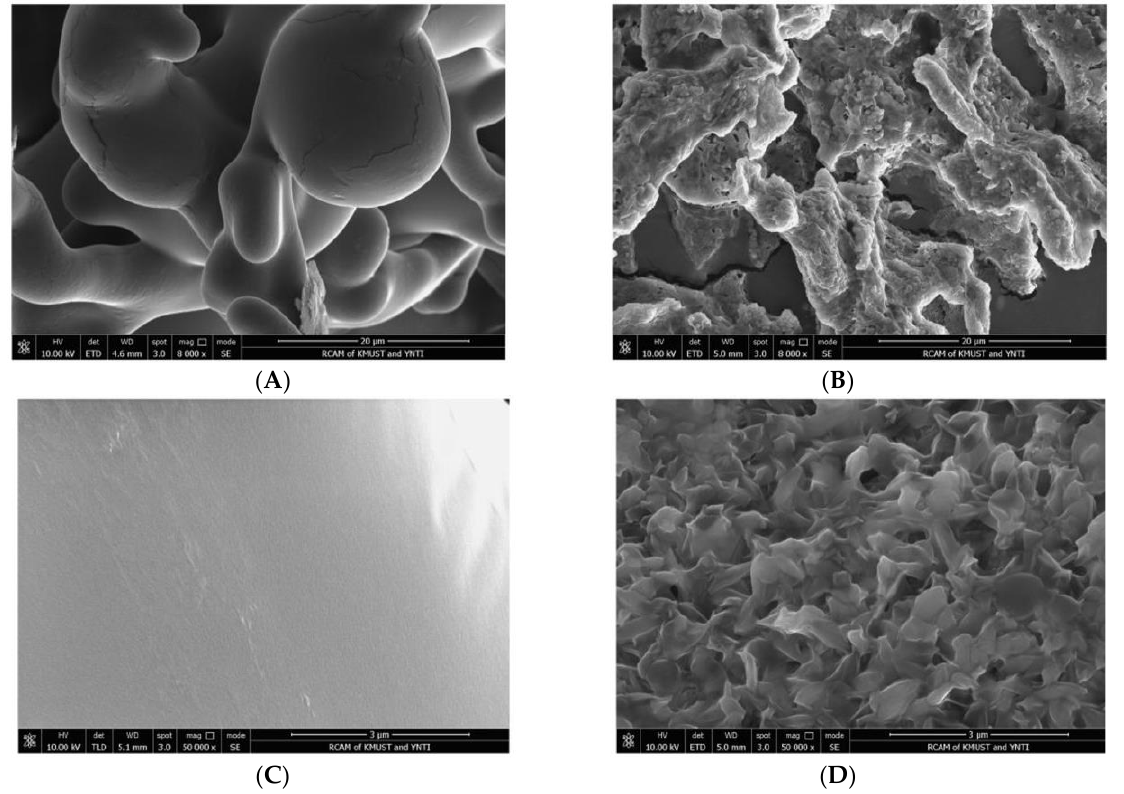
Figure 6. Scanning electron microscope images of DGPSGPK and DGPSGPK-Ca. ( A ) DGPSGPK at ×8000 magnification, ( B ) DGPSGPK-Ca at ×8000 magnification, ( C ) DGPSGPK at ×50,000 magnification, ( D ) DGPSGPK-Ca at ×50,000 magnification.